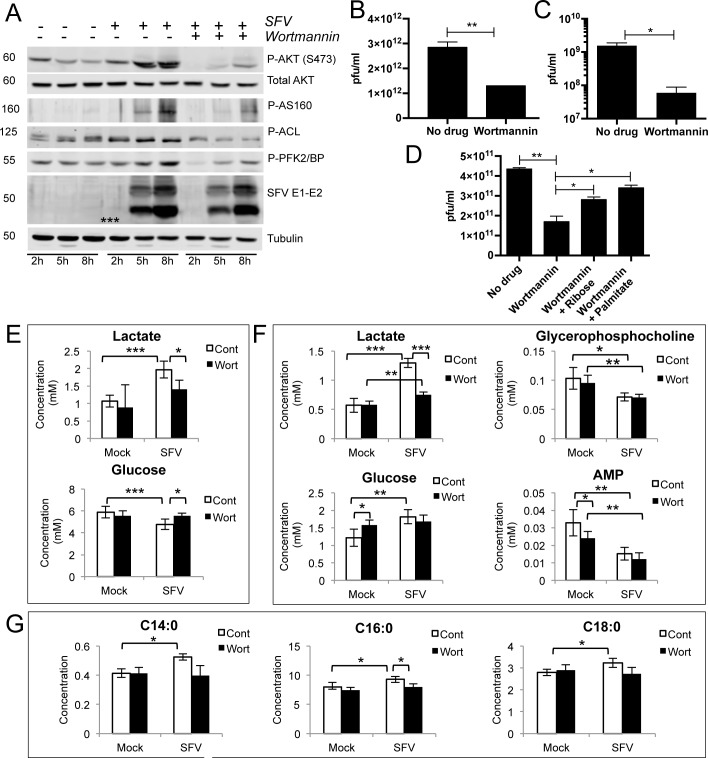
The PI3K inhibitor Wortmannin antagonises SFV-induced AKT activation, glycolysis, and production of new virions.A. Kinetics of activation of AKT and downstream targets in SH-SY5Y cells infected with SFV at MOI 5, in the presence or absence of 10 μM Wortmannin, administered at the same time as SFV infection. Synthesis of new virions from SFV-infected SH-SY5Y (B) or rat primary cortical neurons (C) after treatment with 10 μM Wortmannin, administered at the same time as SFV infection (MOI 3). After 16h, virions in the supernatant were quantified by plaque assay. D. Synthesis of new virions from SFV-infected SH-SY5Y after treatment with Wortmannin alone, or together with 40 mM ribose or 400 μM BSA-conjugated palmitate, administered at the same time as SFV infection (MOI 3). After 16h, virions in the supernatant were quantified by plaque assay. Data are presented as means ± SEM. Concentrations (in mM) of E. lactate and glucose in the media, and F. lactate, glucose, glycerophosphocholine and AMP in the cells, in mock- or SFV-infected samples treated with Wortmannin or DMSO control (8 hpi). G. Levels of selected cellular fatty acids in mock- or SFV-infected cells treated with Wortmannin or DMSO. Six samples per group were analysed. Data are presented as means ± SD. Statistics as in Fig 1. ANOVA was performed when comparison included more than two groups.